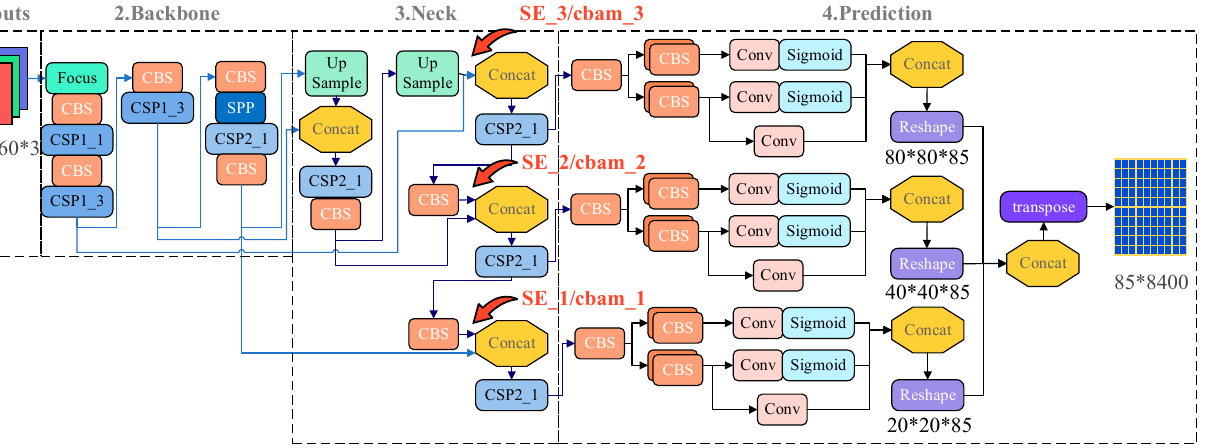
Figure 4. Schematic diagram of YOLOX_s network structure with SE Net and CBAM insertion.